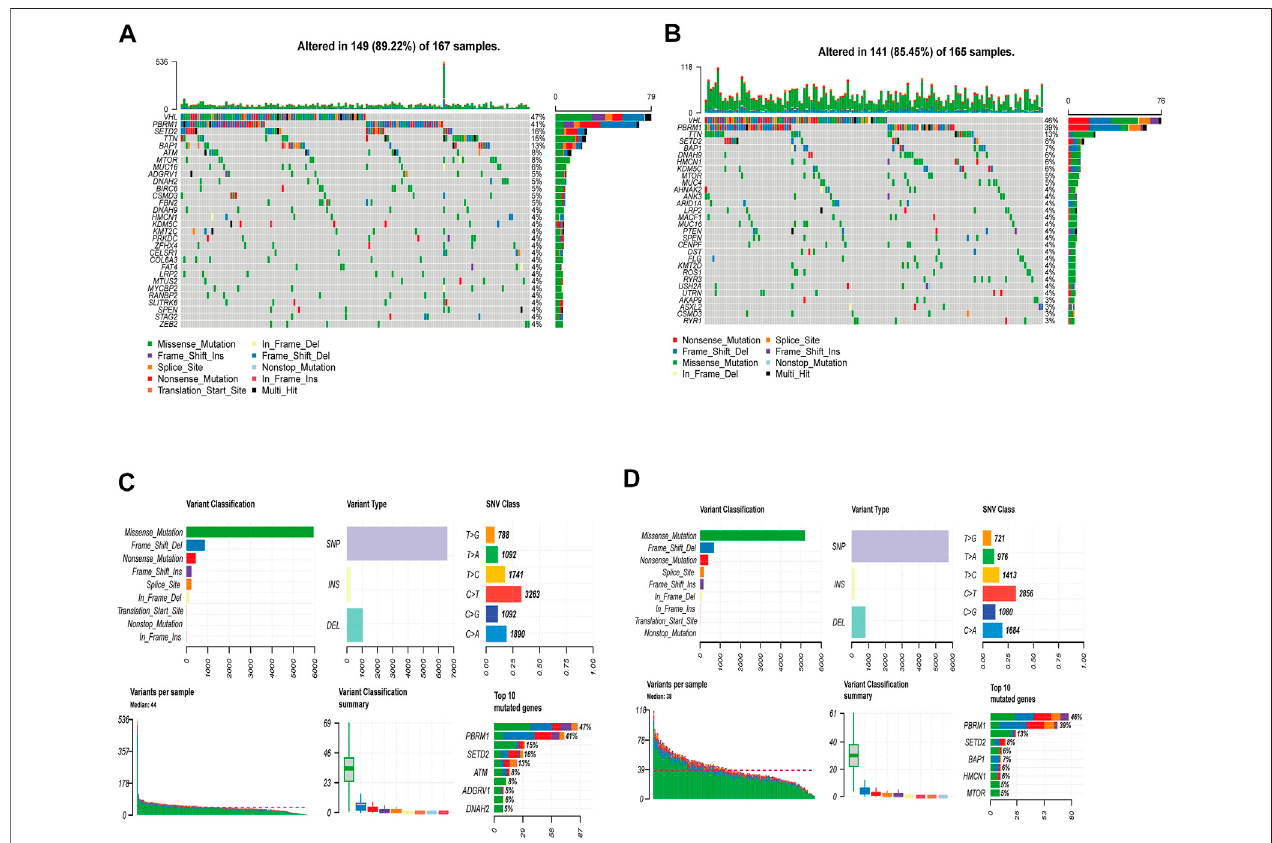
FIGURE6| Mutationanalysisbasedonm6AlRsPI subgroups. (A) Thewaterfallplotdemonstratedmutationalgenesinhighm6AlRsPIgroup. (B) Mutationalgenes in low m6AlRsPI group. (C) Summary for mutation in high m6AlRsPI group. (D) Summary for mutation in low m6AlRsPI group.